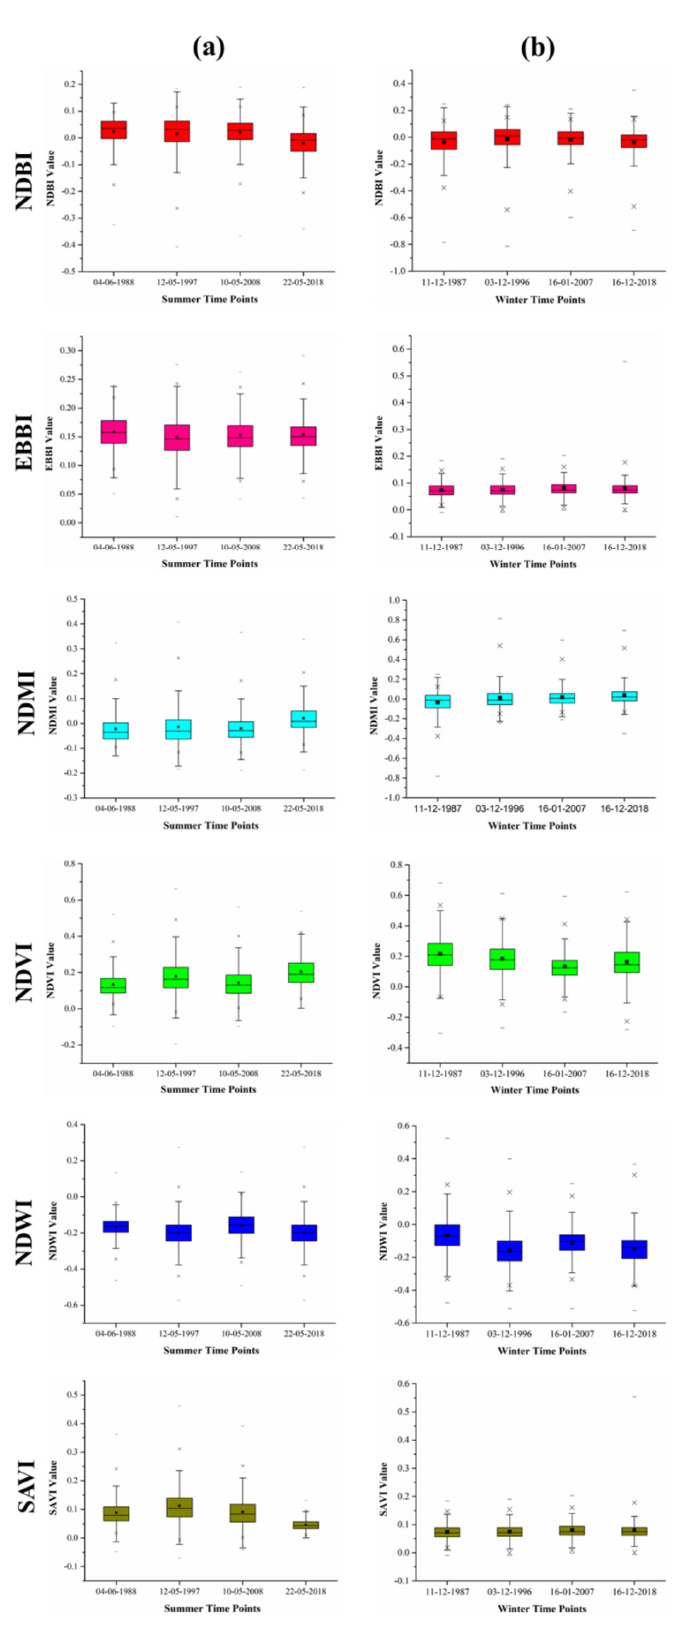
Figure A1. Seasonal whisker boxplots of the six land indices: ( a ) summer and ( b ) winter.